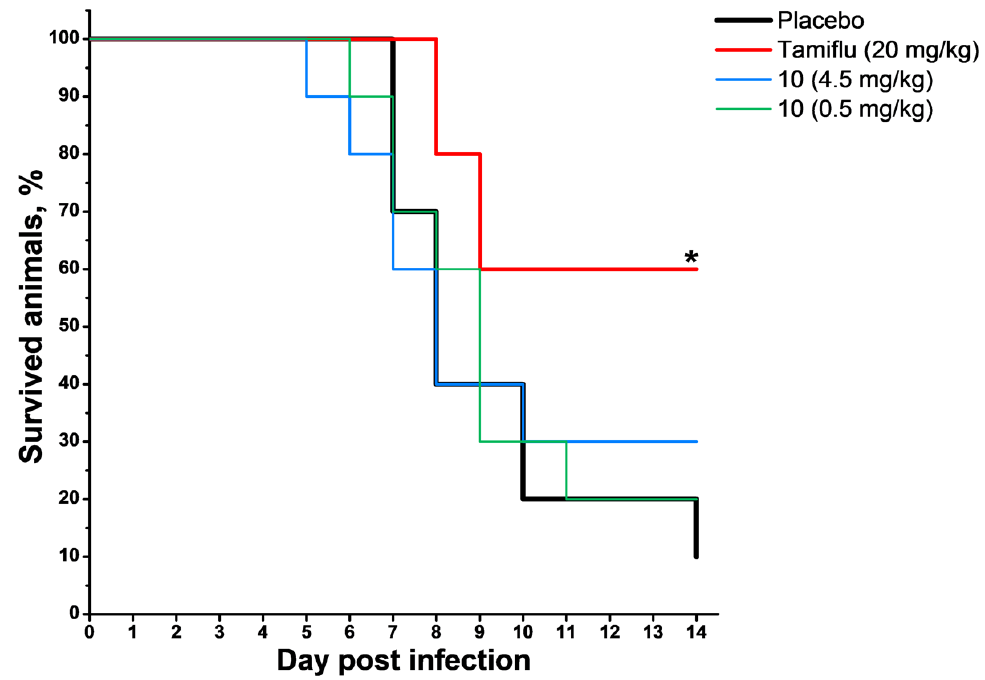
Figure 1. Kaplan – Meier survival curves during experimental influenza pneumonia in BALB/c mice Figure 1. Kaplan–Meier survival curves during experimental influenza pneumonia in BALB/c mice upon infection with influenza A/California/7/09/MA virus (N = 10); * — difference between Placebo upon infection with influenza A/California/7/09/MA virus (N = 10); *—difference between Placebo and Tamiflu groups is statistically significant ( p = 0.02084). and Tamiflu groups is statistically significant ( p =